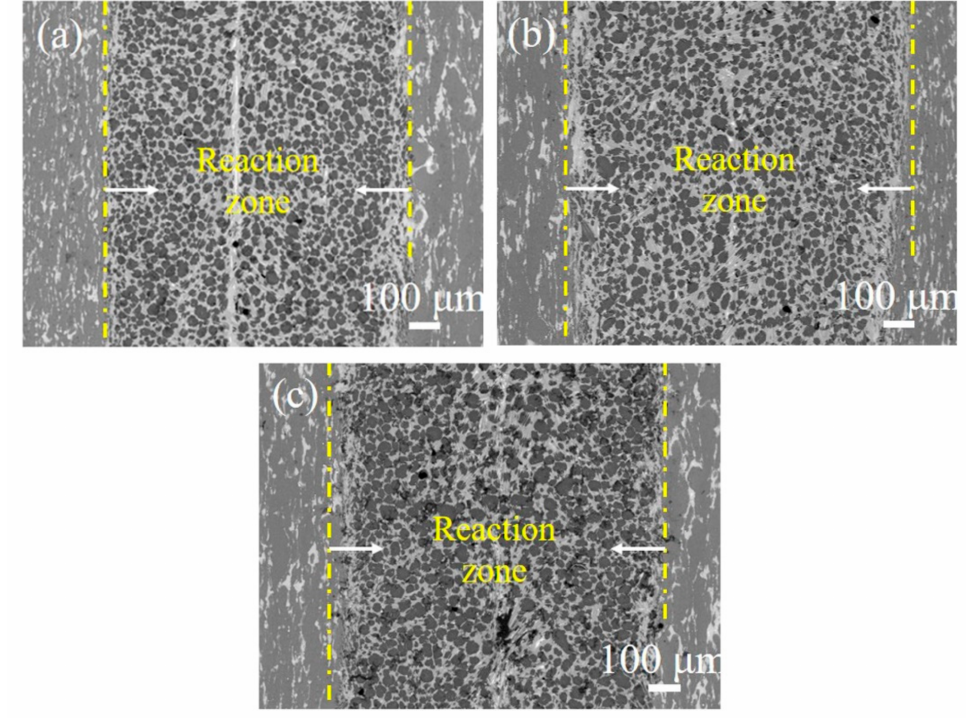
Figure 10. Microstructure of the diffusion bonding joint at 440 ◦ C with different roughness of interface. ( a ) 180# ( b ) 800# ( c )